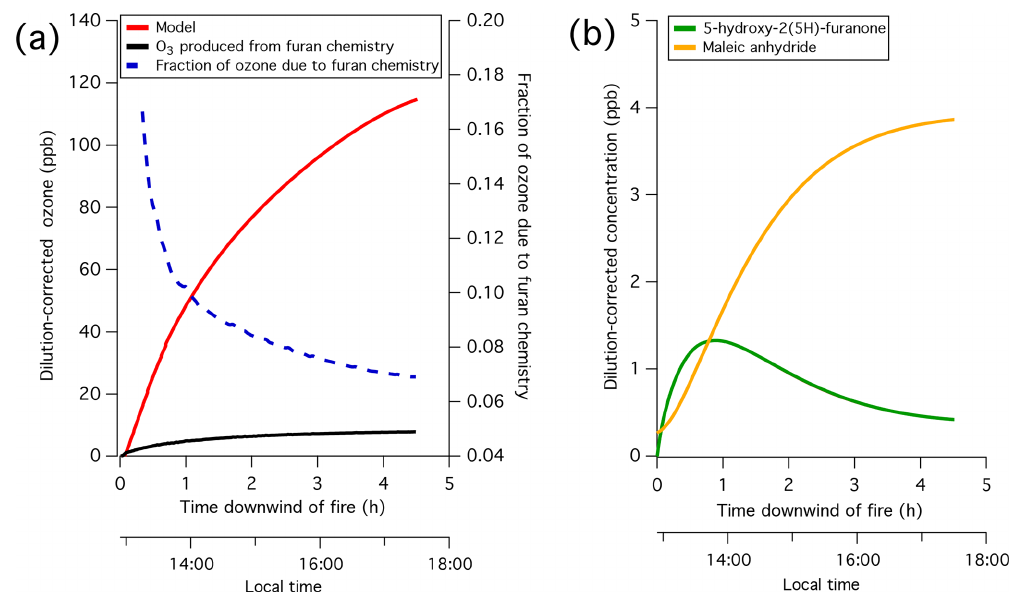
Figure 11. (a) Total ozone, estimated ozone produced by furan chemistry, and fraction of total ozone associated with furan chemistry for the modeled biomass burning plume measured by Müller et al. (2016). (b) Model predictions of 5-hydroxy-2(5H)-furanone and maleic anhydride production. Shown is an extrapolation of the 1h model described in Sect. 3.2.4. After 10min of oxidation, furan chemistry is responsible for >15% of total ozone production in the model. The predicted contribution from furan chemistry decreases as furans are consumed and other, slower-reacting primary NMOGs begin to oxidize. Furan chemistry contributes ∼ 8ppb of ozone after 4.5h of